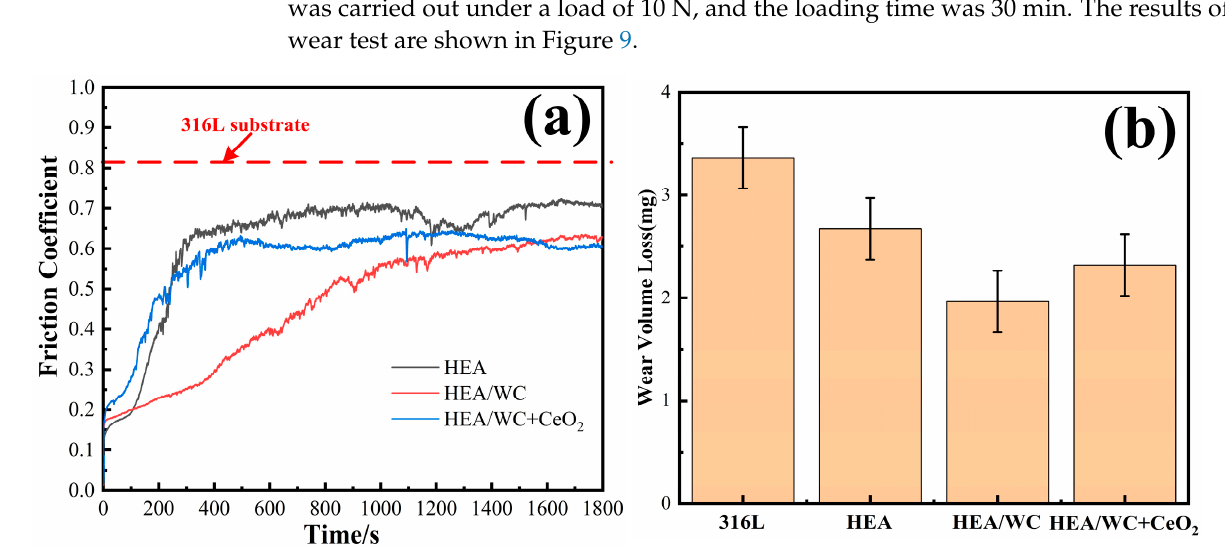
Figure 9. The results of the wear test: ( a ) friction coefficient curves; ( b ) wear amount.